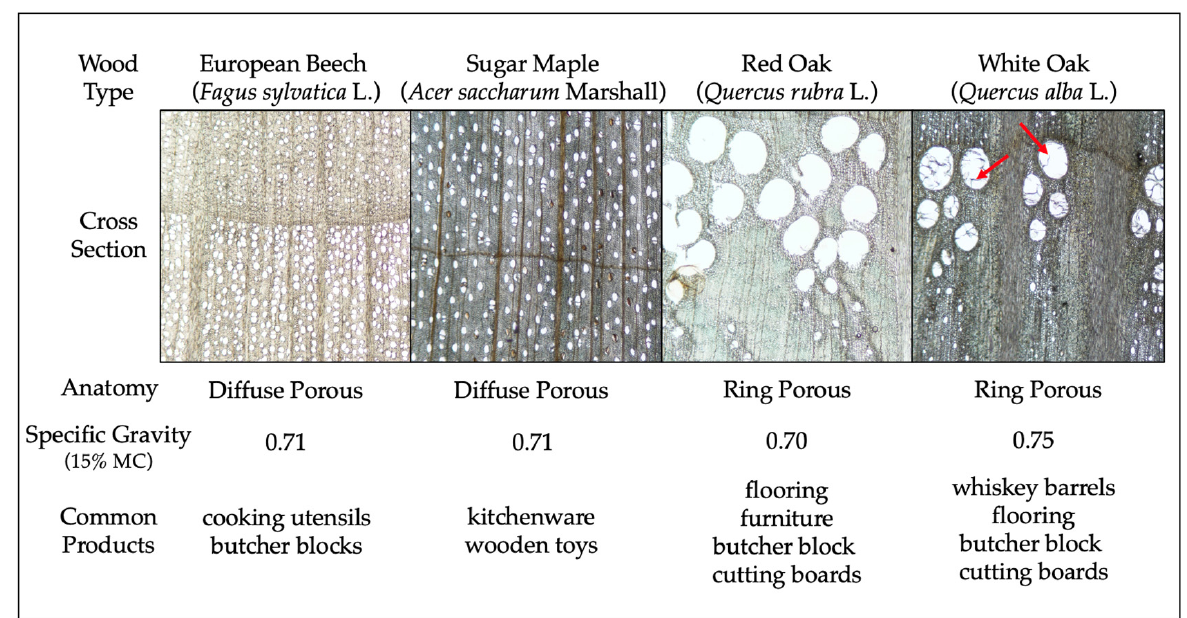
Figure 1. End grain characteristics of wood types that were coated with mineral or linseed oil and evaluated for their ability to support the survival of Listeria innocua and Salmonella Typhimurium. Red arrows in the white oak cross section indicate tvloses.